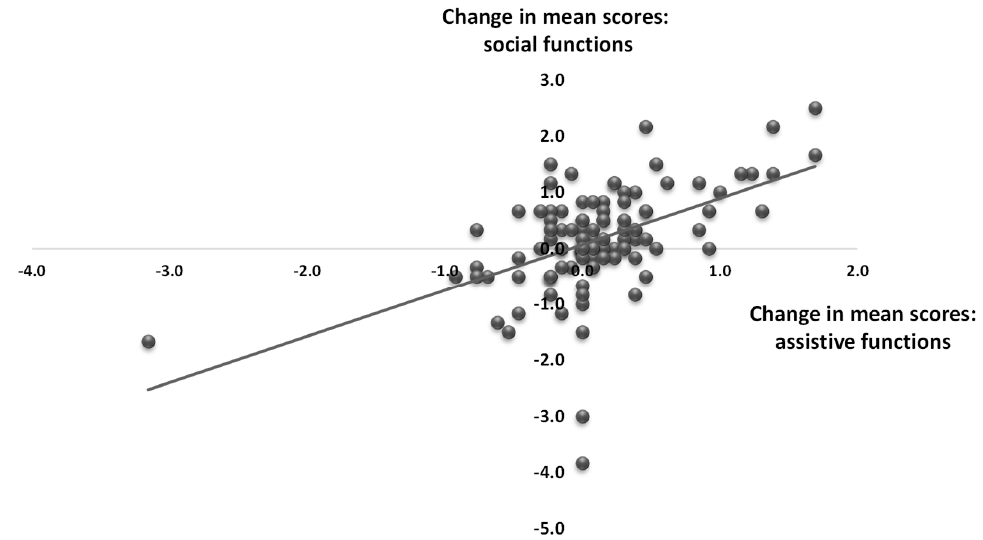
the elderly person —increased significantly ( p < 0.001). However, the mean total scores for both assistive and social functions were also higher after the interaction (area B: 4.5 ± 0.3 vs. 4.6 ± 0.2– p < 0.05; area C: 4.2 ± 0.2 and 4.3 ± 0.2– p < 0.05). Moreover, a positive correla ‐ tion was found between opinion changes in social and assistive functions (r = 0.4842; p =